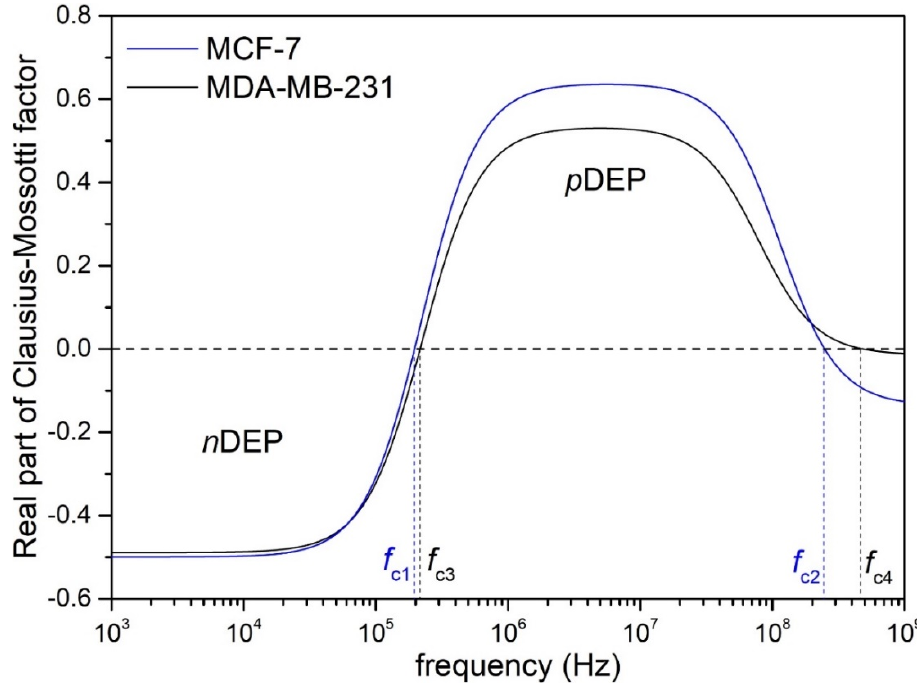
Figure 5. The real part of the Clausius-Mossotti factor (Re(CM)) as a function of the frequency of alternative electric field (AC EF). The figure consists of two CTCs: MCF − 7 and MDA − MB − 231. Negative dielectrophoresis (nDEP) and positive dielectrophoresis (pDEP) are indicated in the figure. The calculations were performed for 0.1 PBS using myDEP software.